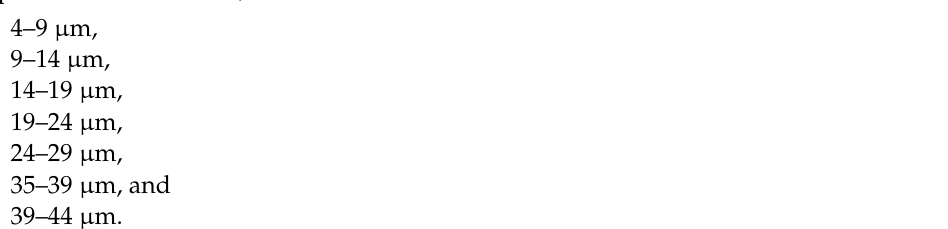
in Table 5; AR dQ : area ratio of detrital quartz; AR dF : area ratio of detrital feldspar; AR dQ/dF/dQ+F : area ratio of bulk detrital quartz or detrital feldspar or detrital quartz and feldspar; AR (9–24)dQ-dQ : area